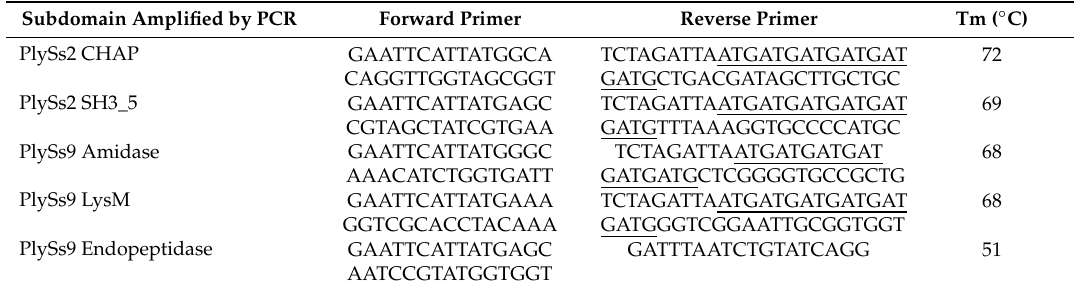
Table 2. Forward and reverse primer sequences and their respective melting temperature (Tm) used to clone the individual subdomains from the parental endolysins by PCR. The coding sequence of the polyhistidine tag is